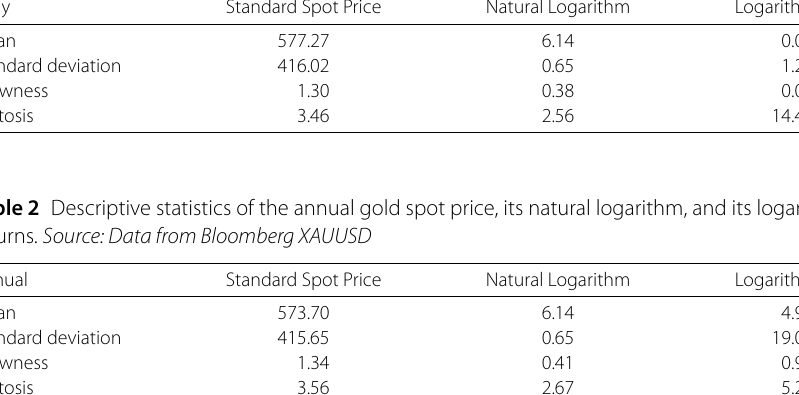
Table 1 Descriptive statistics of the daily gold spot price, its natural logarithm, and its logarithm returns. Source: Data from Bloomberg XAUUSD Daily Standard Spot Price Natural Logarithm Logarithm return Mean 577.27